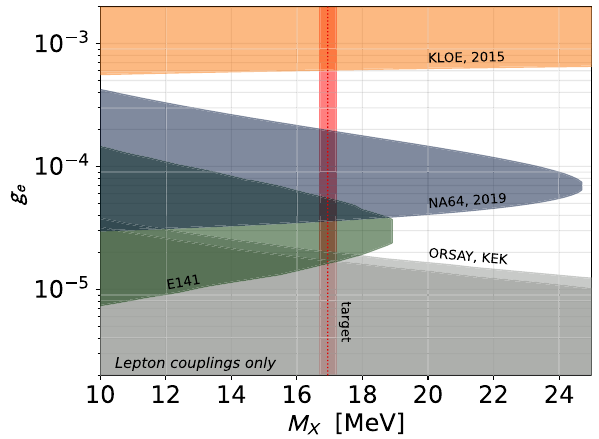
Fig. 35 Dominant constraints on the couplings of a new vector boson with e ± from accelerator-based experiments only. We show the limits fromKLOE[171](orangeregion),NA64[15](blueregion),E141[167] (green region) and the KEK and Orsay experiments [168,169]. The red band represents the X 17 mass target from